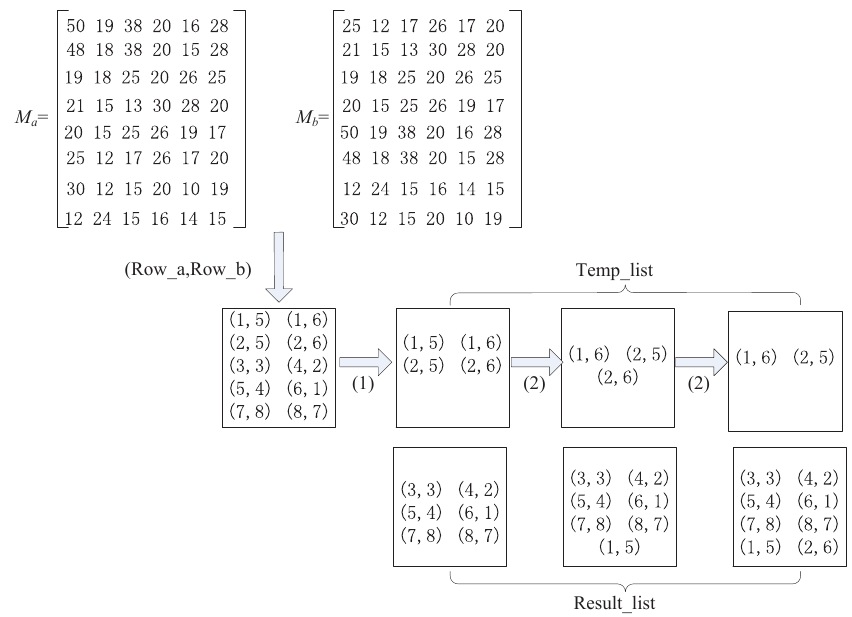
Figure 7. Example 2 for the SUL